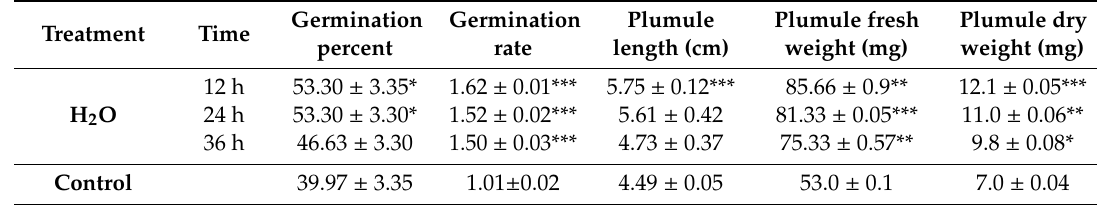
Table 3. The e ff ect of caraway seed hydro-priming with distilled water (DW) germination percentage, germination rate, plumule length, plumule fresh weight and plumule dry